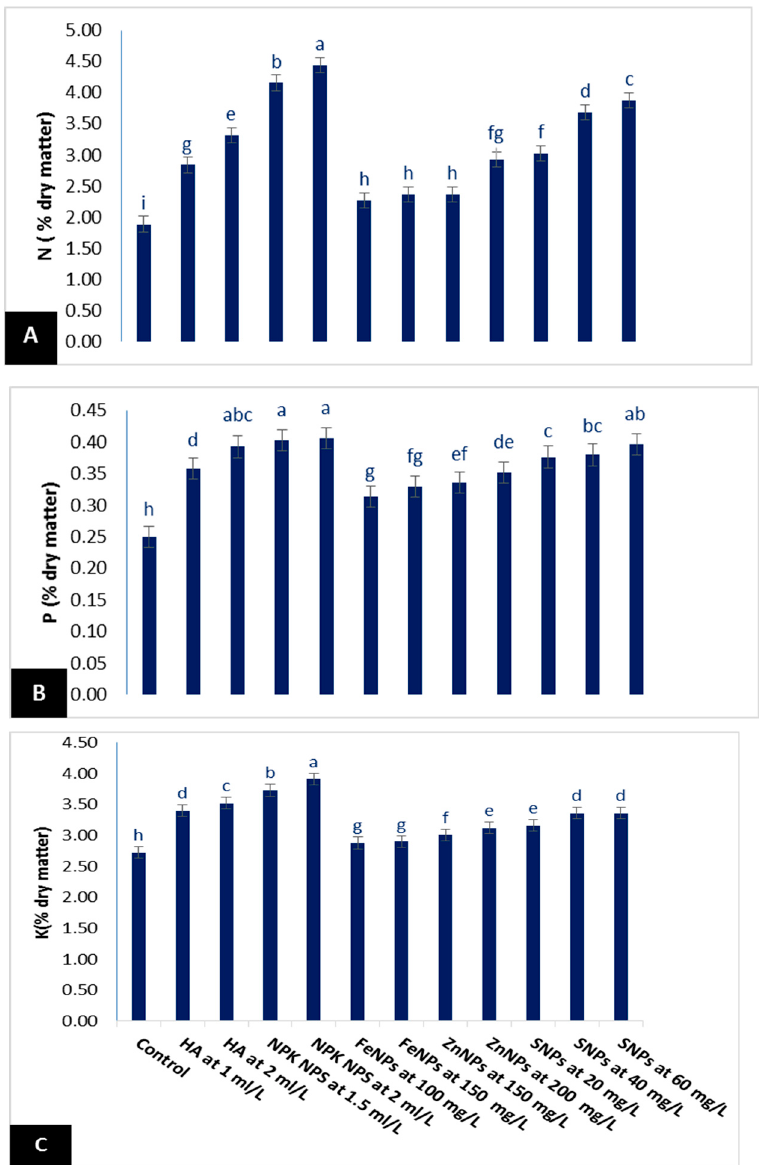
Figure 3. Effect of nanoparticles and humic acid on nitrogen ( A ), phosphorus ( B ), and potassium ( C ) contents (% dry matter) in Philodendron bipinnatifidum . The same letters show no significant differences between the treatments according to ANOVA, Duncan’s multiple range test at 0.05 level. Data are the mean of both seasons (±SE) of three replicates.